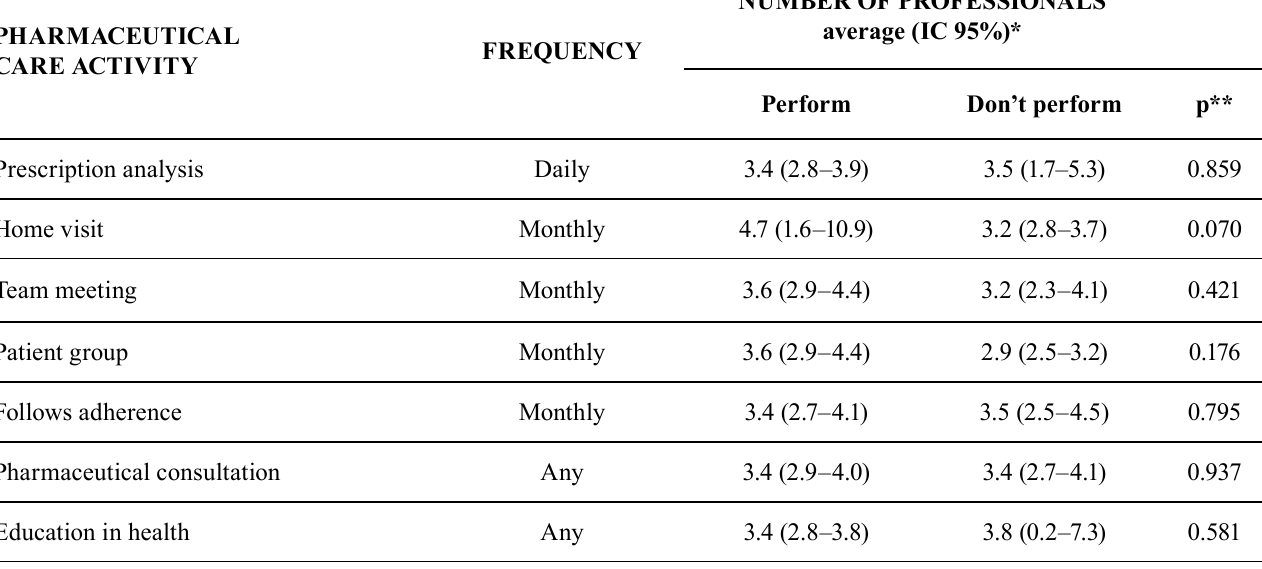
TABLE IV – Association of the number of professionals in the pharmacy with the frequency of Pharmaceutical Care activities in the primary health center (UBS) of São Bernardo do Campo,